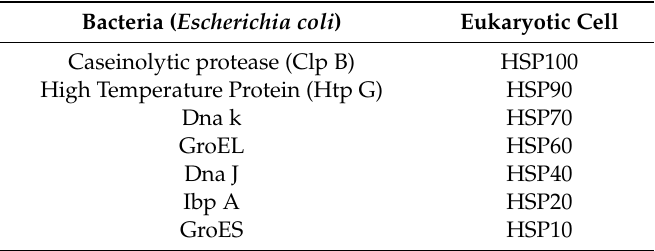
Table 1. Nomenclature of HSPs in prokaryotes and eukaryotes.